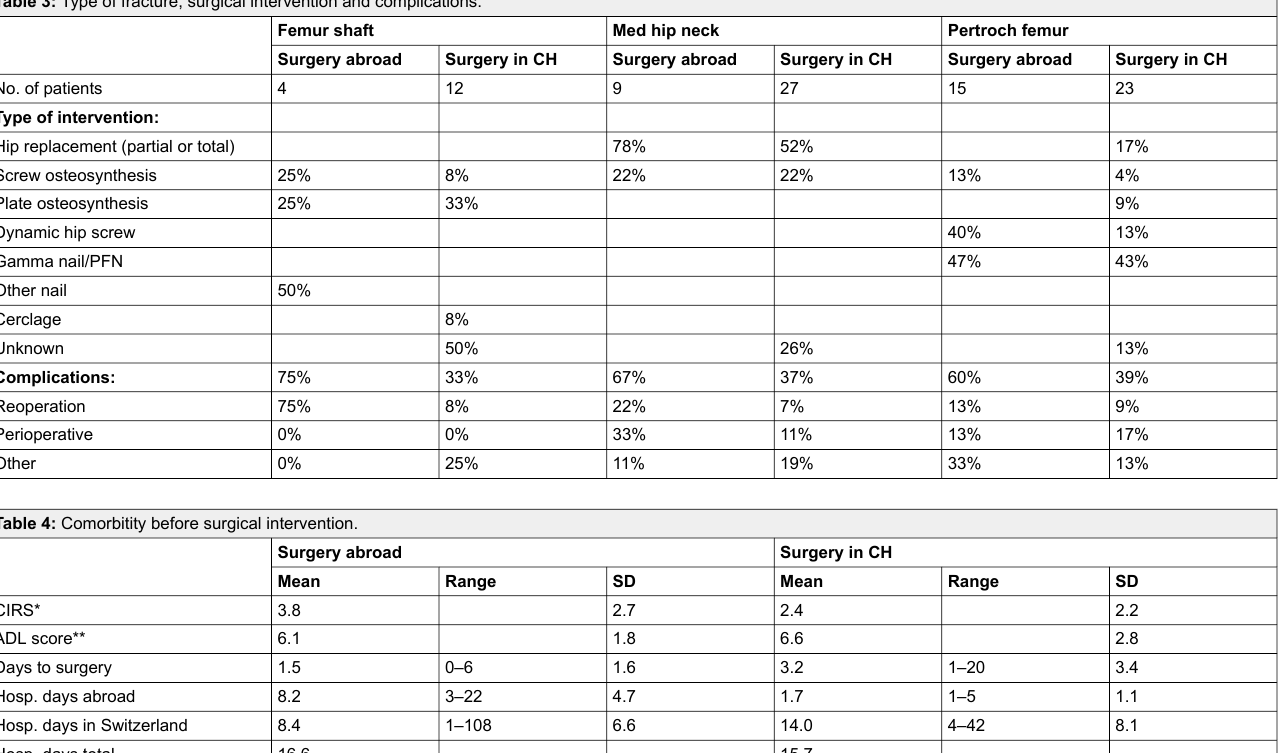
Table 3: Type of fracture, surgical intervention and complications. Femur shaft Med hip neck Pertroch femur Surgery abroad Surgery in CH Surgery abroad Surgery in CH Surgery abroad Surgery in CH